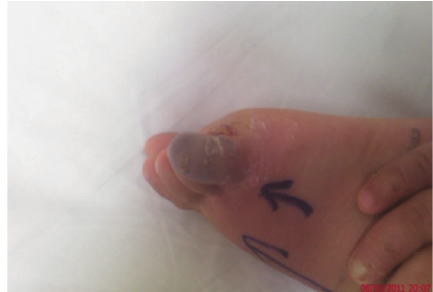
Figure 1: Photograph of the right foot showing necrosed right little toe resulting from severe infection before amputation at age of 2.8 years.